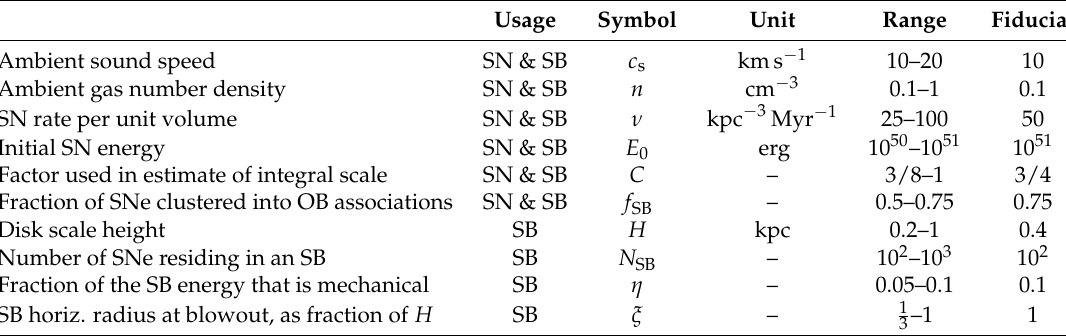
Table 1. The underlying interstellar medium (ISM) parameters with adopted values. ‘Usage’ designates whether the parameter is needed to model isolated supernova (SN) driving or superbubble (SB) driving. (If either SBs or isolated SNe are neglected, then f SB = 0 or f SB = 1, respectively.) The range suggests plausible values for Milky Way-like galaxies, but the model is not restricted to this range. The fiducial values refer to typical estimates for the Solar neighbourhood of the Milky Way, averaged across the Galactic disc [40]. Usage Symbol Unit Range